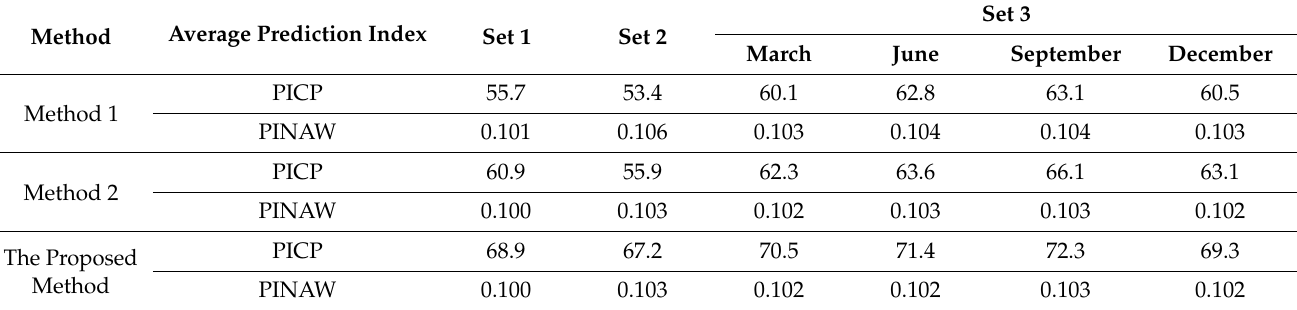
Table 6. Accuracy comparison with different interval prediction methods in different datasets.